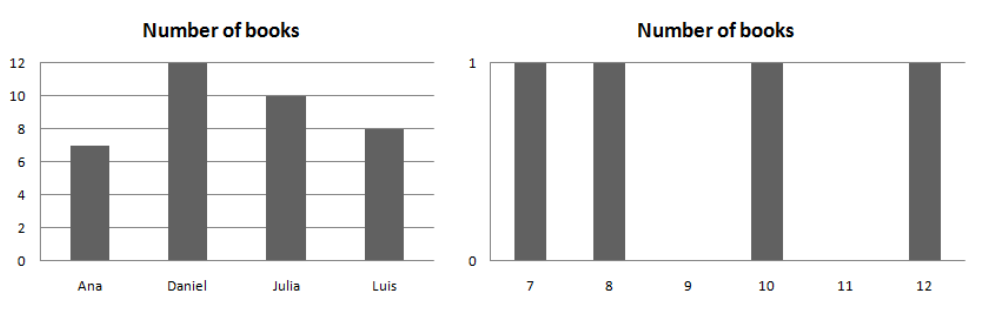
Figure 1. Incorrect ( left ) and correct ( right ) representation of the statement